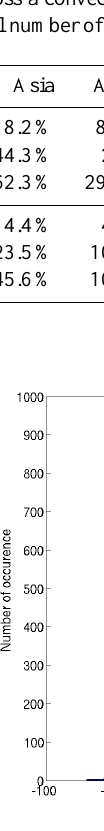
Fig. 17. Distribution of the smallest difference between the tem- perature at back-trajectory altitude and its surrounding brightness temperature along individual